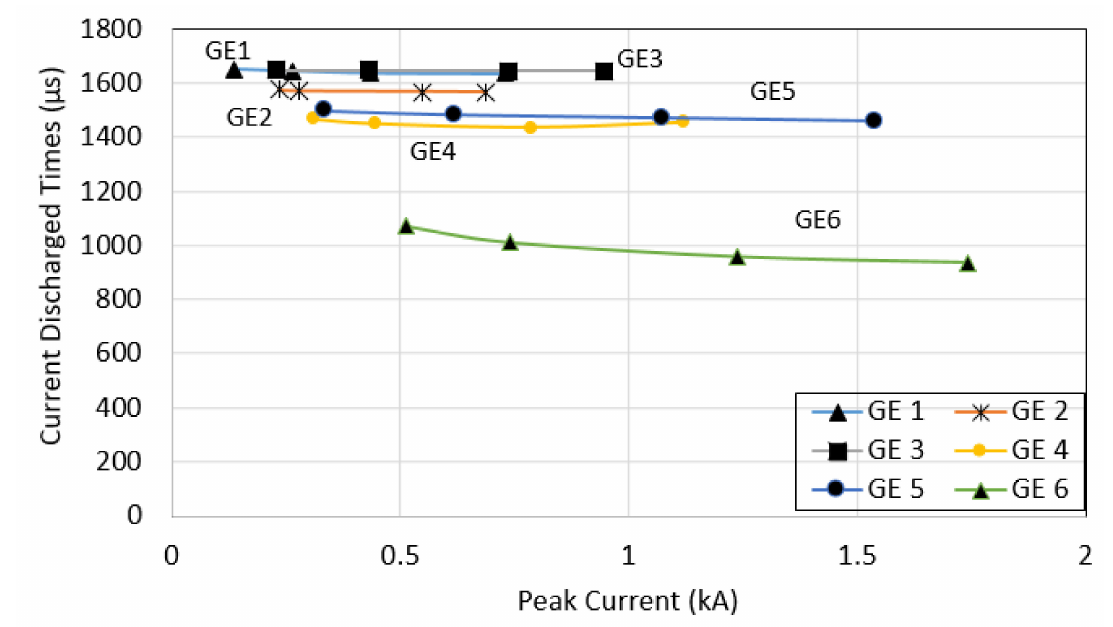
Figure 6. Current discharged times for GEs at various peak current magnitudes under positive impulse polarity.